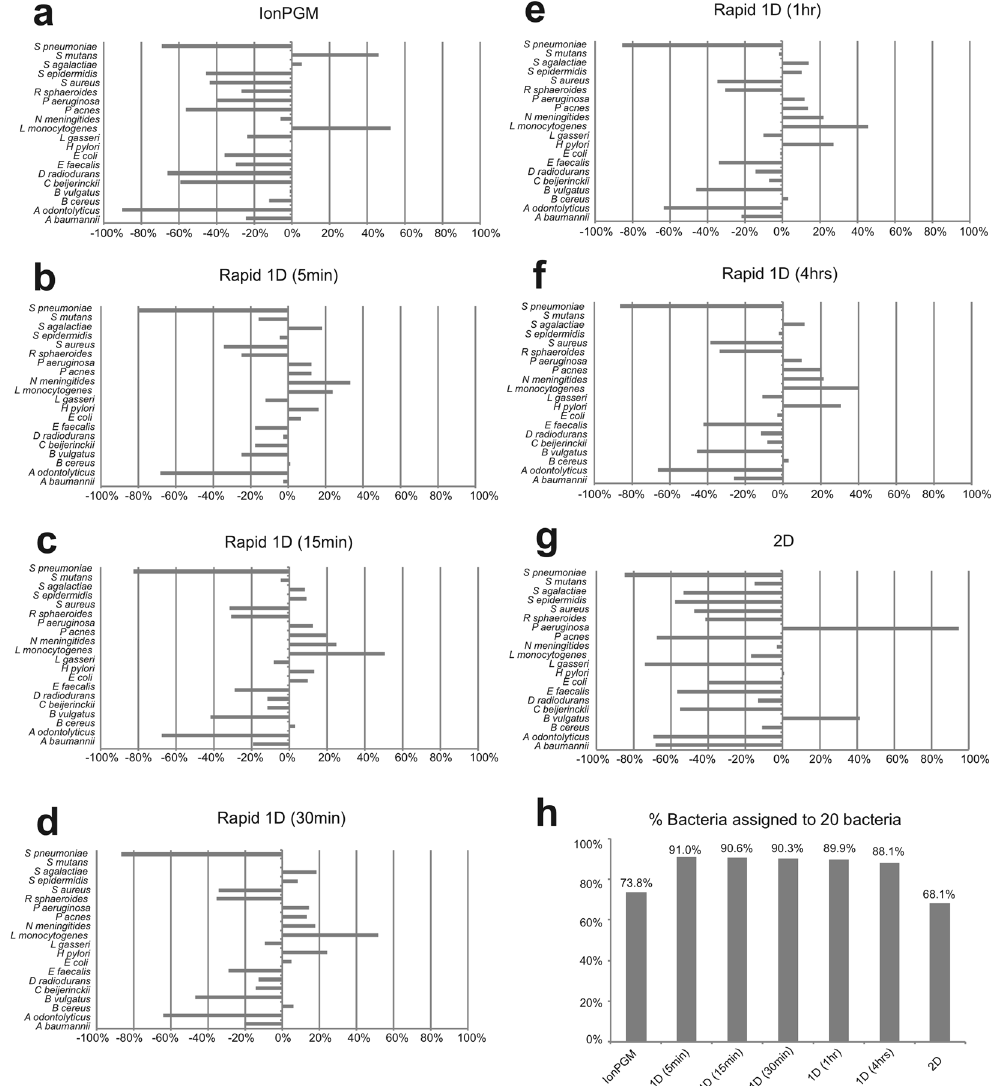
Figure 2. Species level bacterial classifications using the Nanonet base-caller and BLAST-based searches. Deviation from the percentage of expected reads to all reads assigned to bacteria are shown ( a – g ). IonPGM sequencing for 16S rDNA ( a ). MinION Rapid 1D Sequencing for near full-length 16S rDNA amplicons for 5 min ( b ), 15 min ( c ), 30 min ( d ), 1 h ( e ), and 4 h ( f ). MinION 2D sequencing for 16S rDNA ( g ). The percentage of reads assigned to any of the 20 bacteria among all reads classified as bacterial reads ( h ). The remaining percentage represents the taxa that were not assigned to the original mock